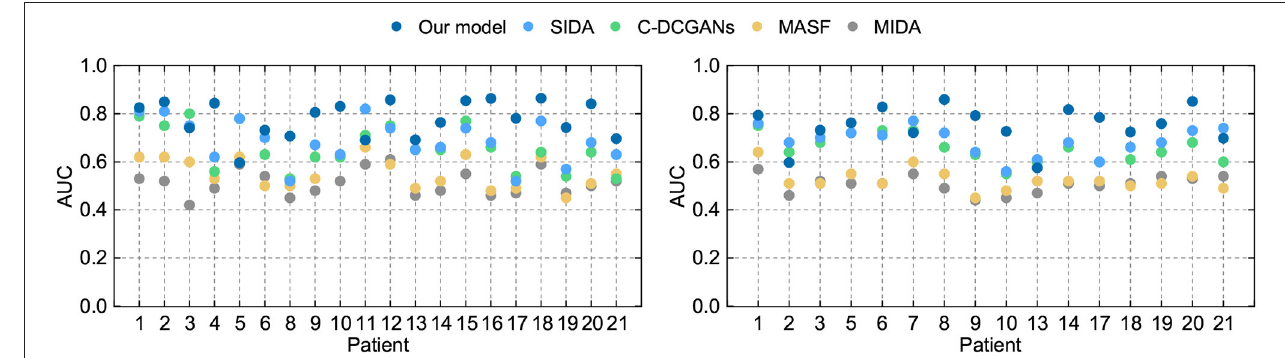
FIGURE 6 | AUC of different DA models on the Freiburg Hospital test set (left) and the CHB-MIT test set (right)